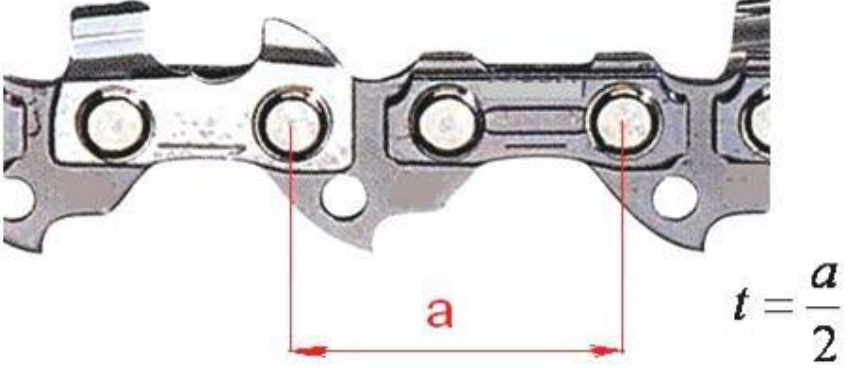
Figure 1. Method of determining saw chain pitch. a: distance between axes everythree rivets; t : saw chain pitch (half the distance between axes every three rivets).